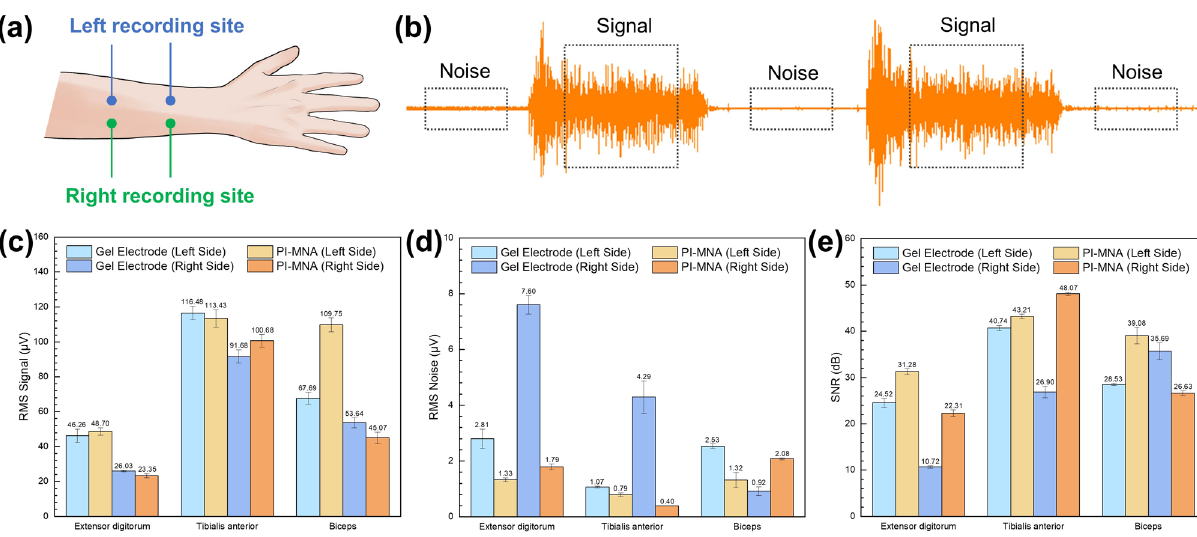
Fig. 7 a Recording sites arrangement for SNR comparison between the PI-MNA and gel electrodes. b Schematic of the extraction for signal and noise segments for SNR analysis. c RMS signal, d RMS noise, and e SNR values calculated from the EMG signals recorded by two electrode types ( n = 5, mean ± standard